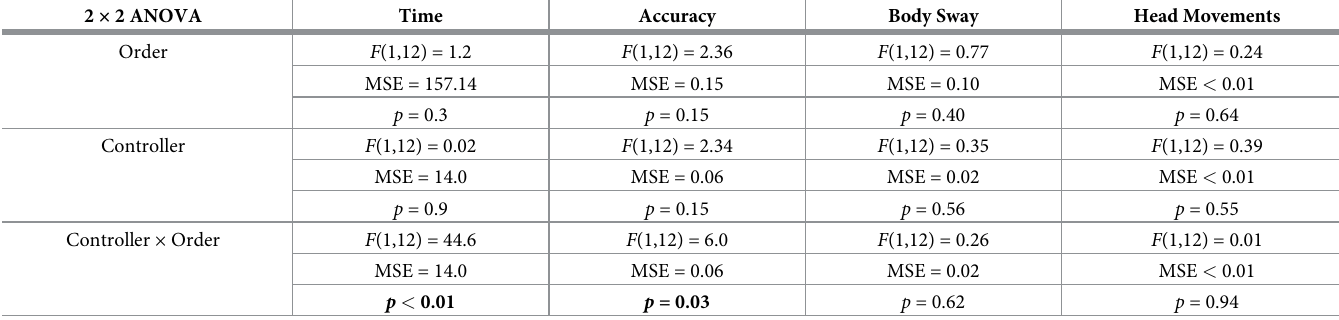
Table 2. Analysis of performance and additional measures from Experiment 1. Significant results ( p < 0.05) are bold. 2 × 2